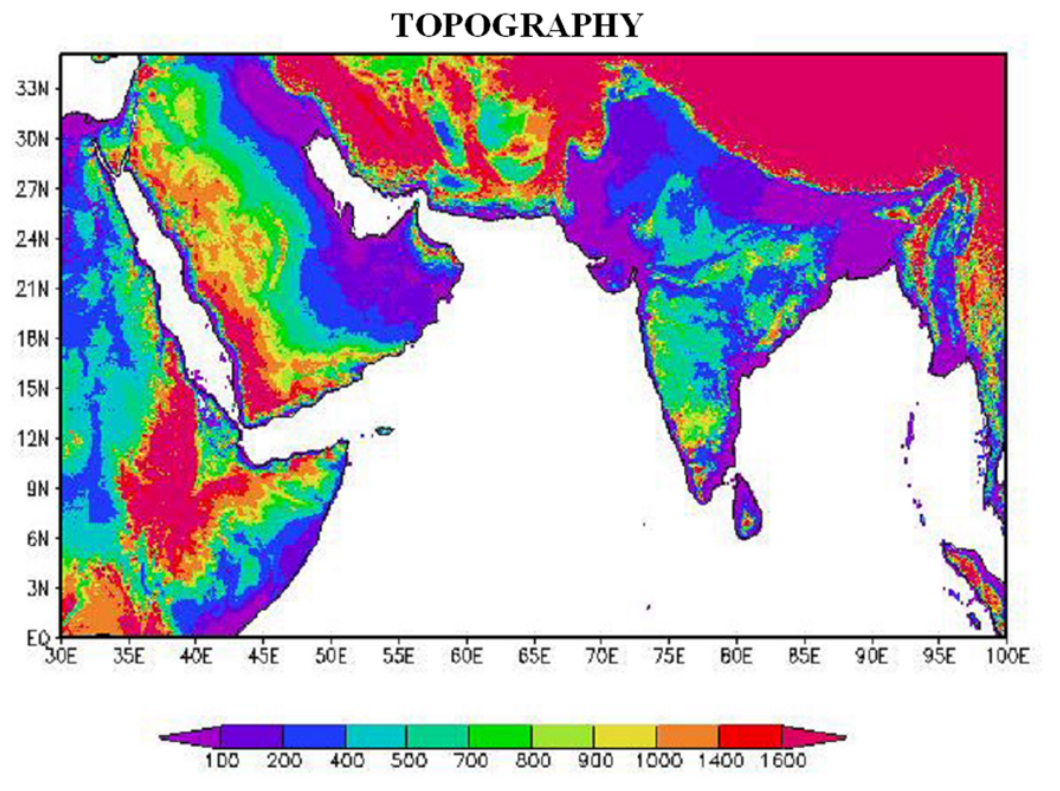
Fig. 8. Topography map of the METEOSAT-5 window